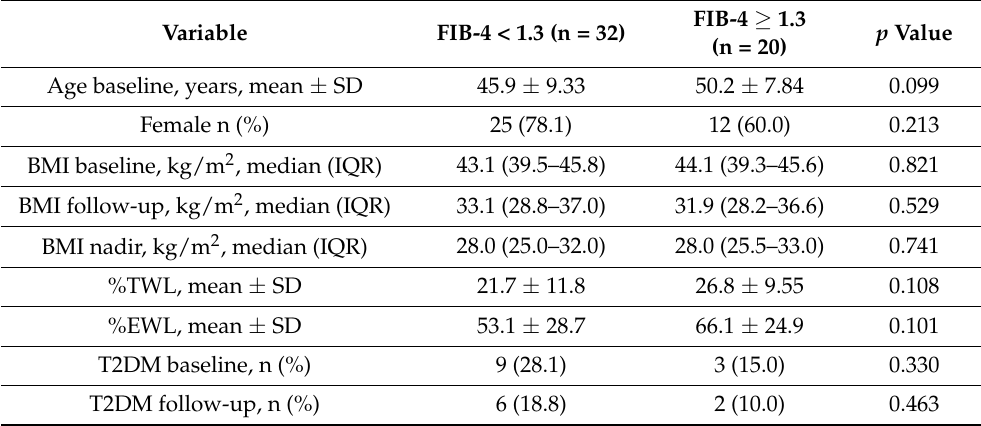
Table 4. Patients with FIB-4 ≥ 1.3 at baseline with improvement in FIB-4 index vs. patients without improvement.